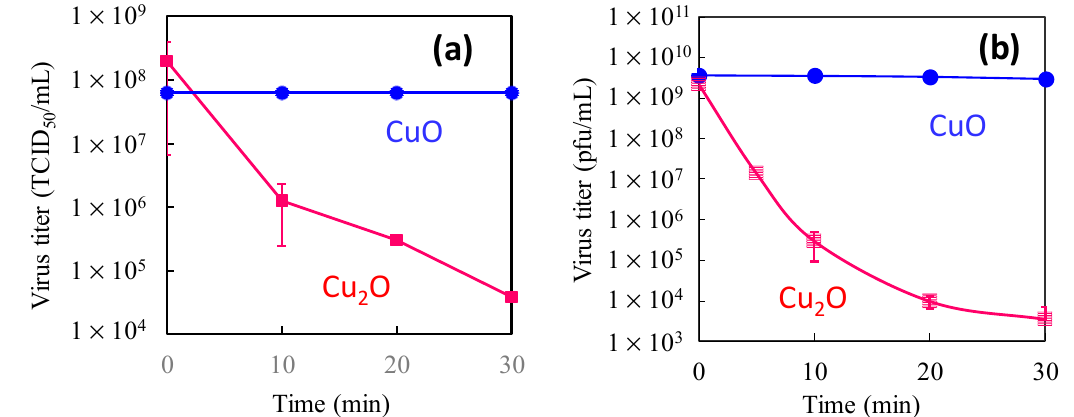
Figure 1. ( a ) Titer of influenza A virus and ( b ) bacteriophage Q β as a function of exposure time to Cu 2 O (red squares) and CuO films (blue circles) [35]. Error bars indicate standard deviations of two or three replicate experiments. CuO and Cu 2 O powder were coated on glass substrates and their antiviral test was examined under room temperature. These experimental methods are based on the